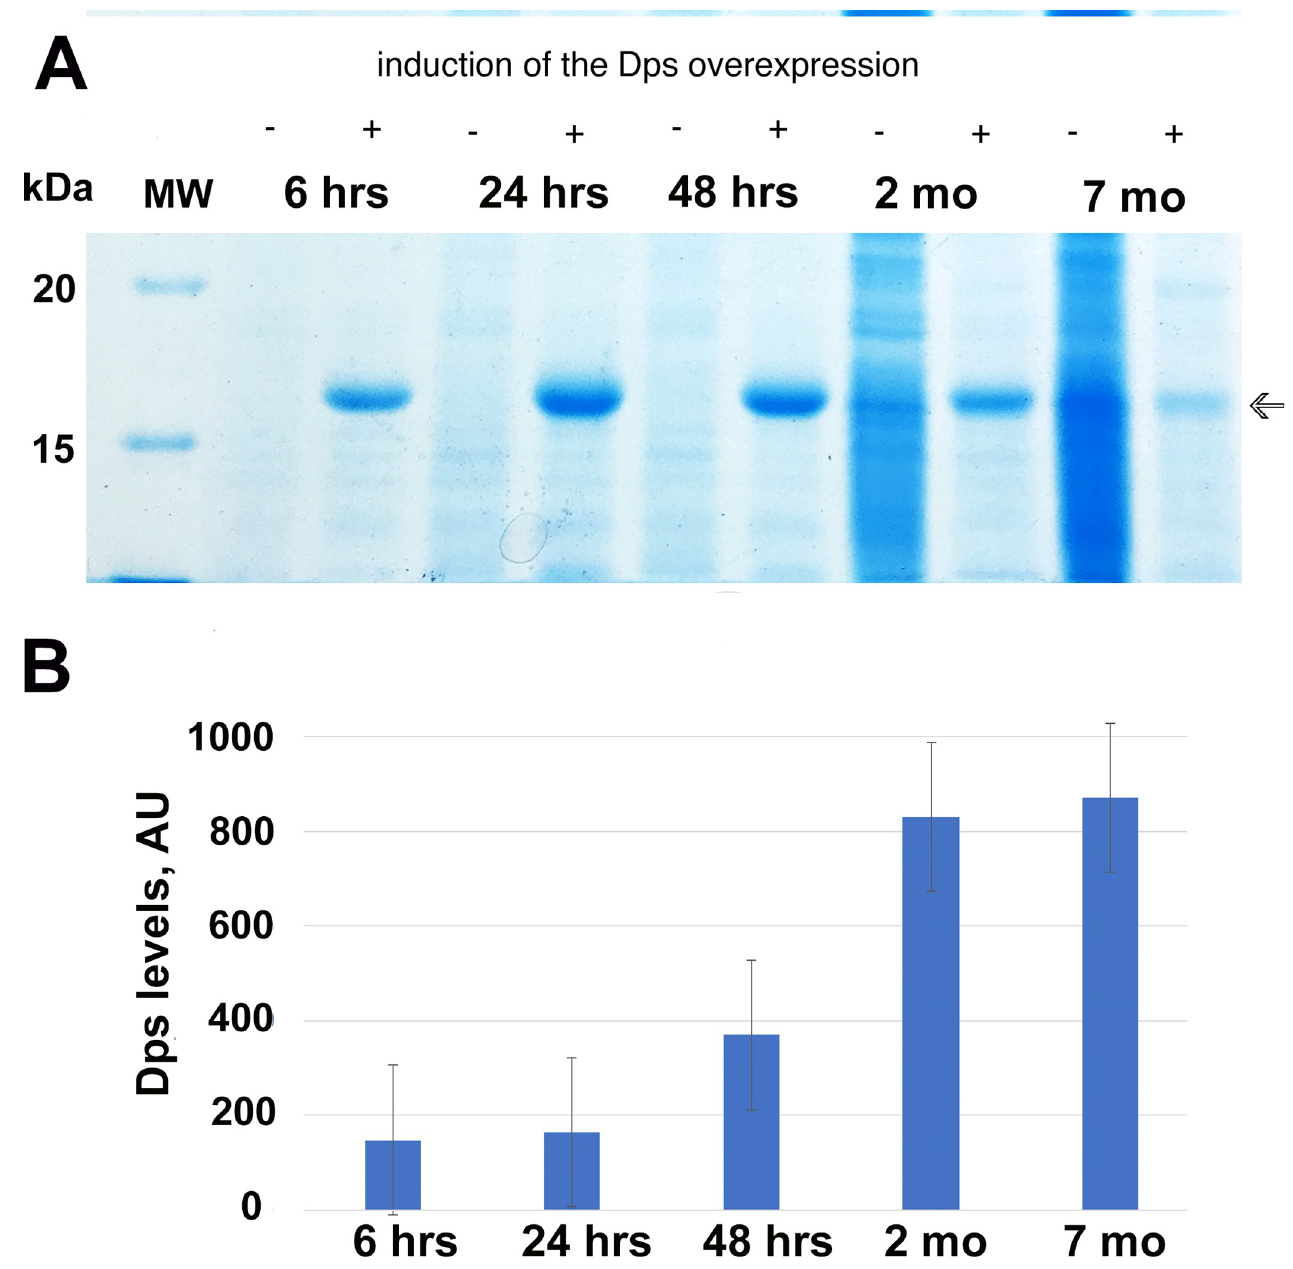
Fig 1. Dps content in the E . coli cells, upon prolonged starvation. (A) SDS-PAGE of the biomass extract. The induction of Dps overproduction was performed at the beginning of linear growth. Arrow–Dps; (B) The averaged amount of Dps (normalized per cell number) in E . coli Top10/pBAD-DPS population of cells at different intervals of